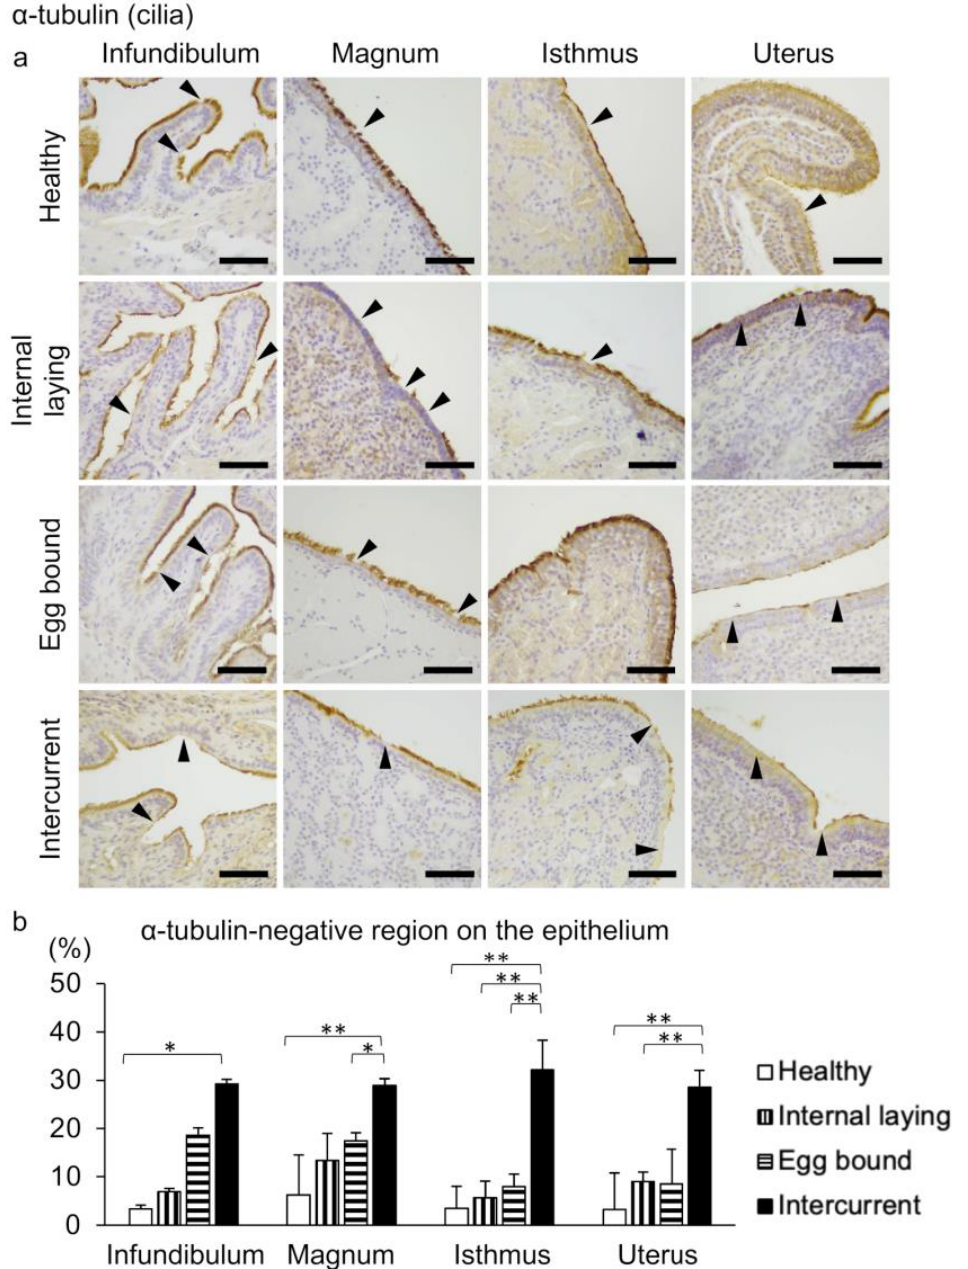
Figure 4. Deficiency of cilia on the oviductal epithelium in laying hens. ( a ) Immunohistochemistry for detecting α -tubulin-positive cilia on the ciliated epithelial cells of oviducts. Arrowheads indicate the α -tubulin-negative regions on the epithelium. Bar = 50 µ m. ( b ) The percentage of α -tubulin-negative region on the oviductal epithelium. * p < 0.05, ** p < 0.01 (Tukey–Kramer test, n = 4 for each group). Data are presented as the mean + SE.